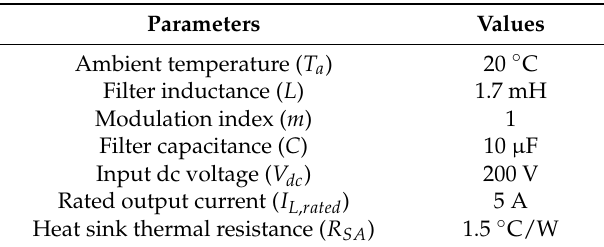
Figure 12. Experimental test-bed. Table 1. The three-phase system parameters.